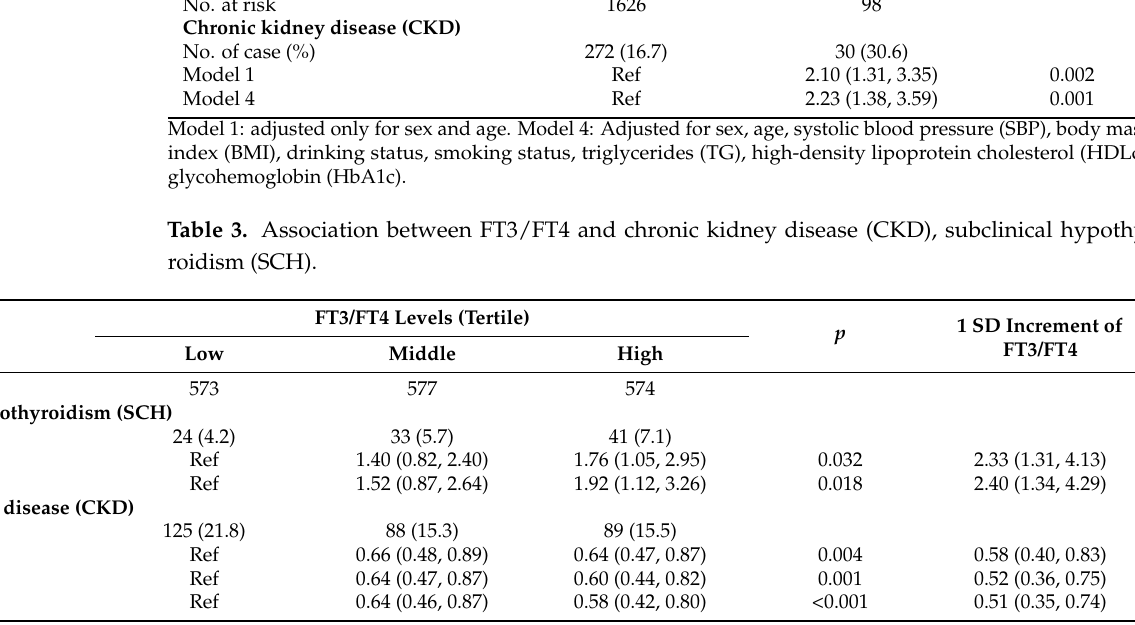
Table 2. Association between subclinical hypothyroidism (SCH) and chronic kidney disease (CKD). Subclinical Hypothyroidism (SCH)